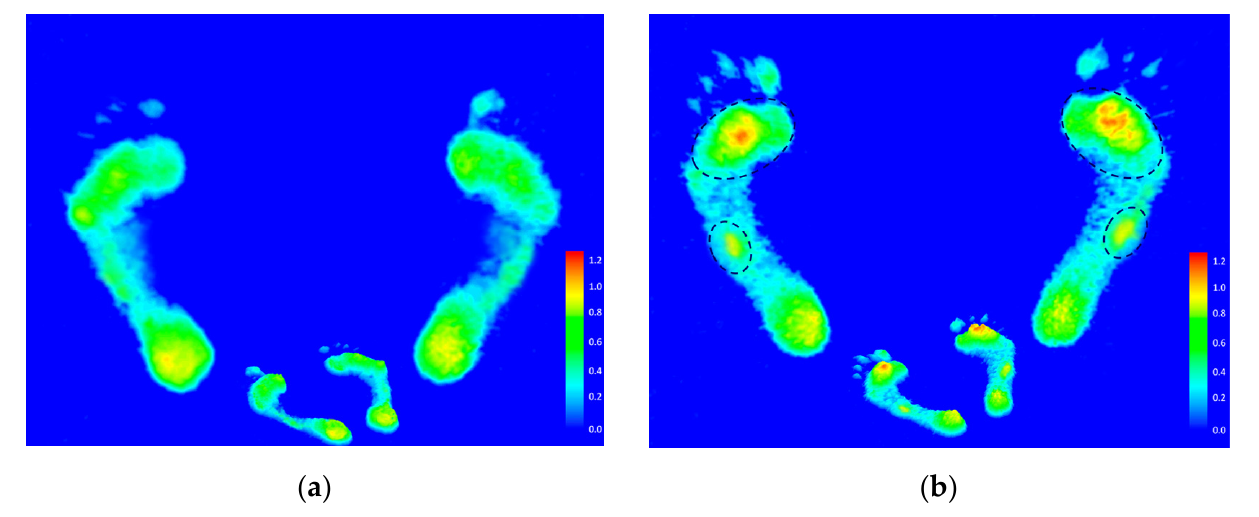
Figure 4. The static footprint image of the recreational group ( a ) and the elite group ( b ). Black circle indicates the areas of higher pressure.